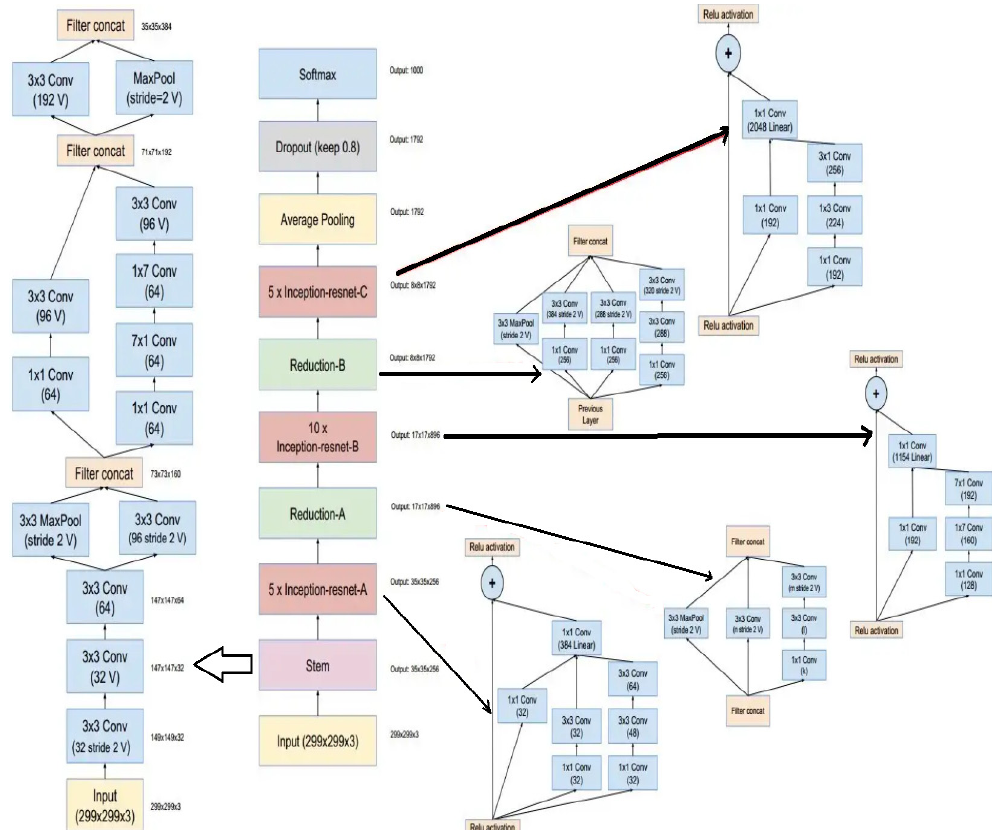
Figure 1. Inception-ResNet-V2 architecture.